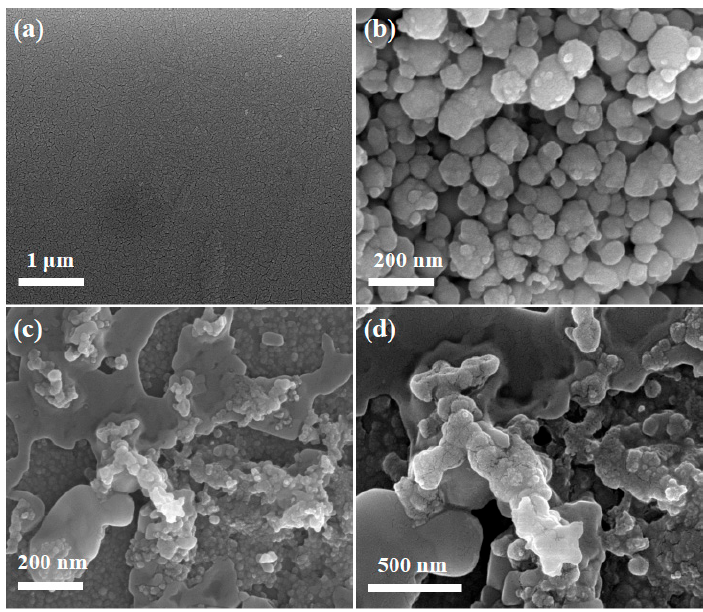
Figure 6. FESEM images of stepwise fabrication of electrode at different magnifications: ( a ) Bare (at 1 μ m), ( b ) SnNPs (at 200 nm), ( c ) Apt MDMA @SnNPs (at 200 nm), and ( d ) Apt MDMA @SnNPs (at 500 nm) .